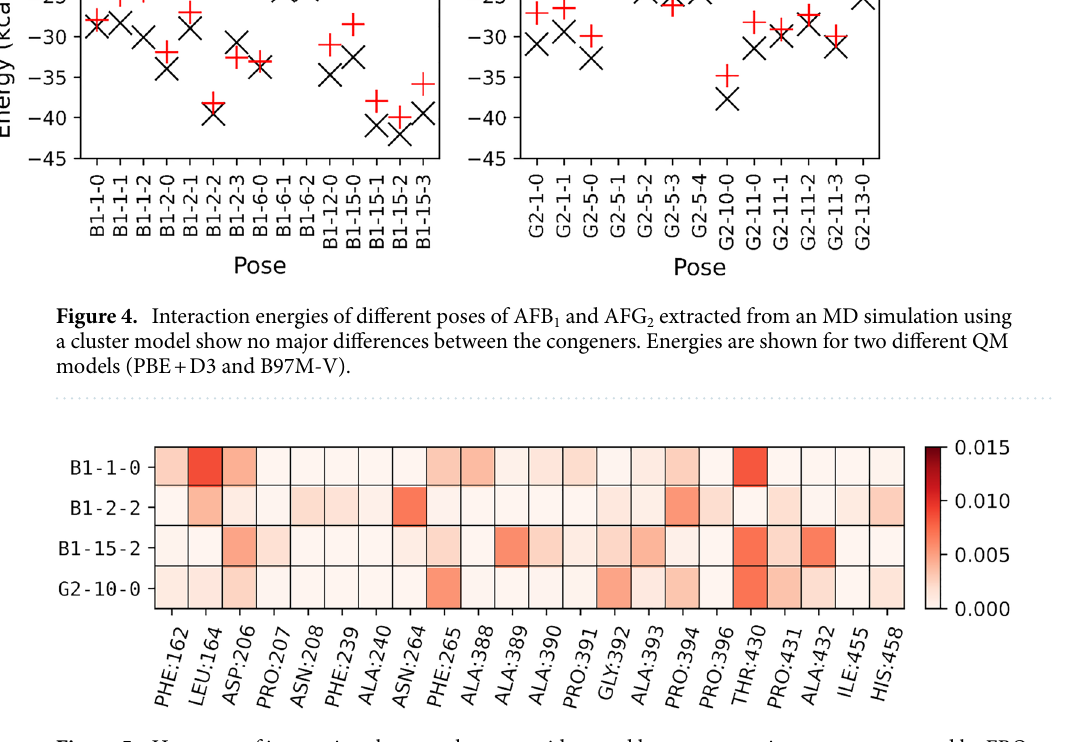
Figure 5. Heat map of interactions between laccase residues and low energy toxin poses as measured by FBO highlights residues of interest. A higher FBO indicates a stronger